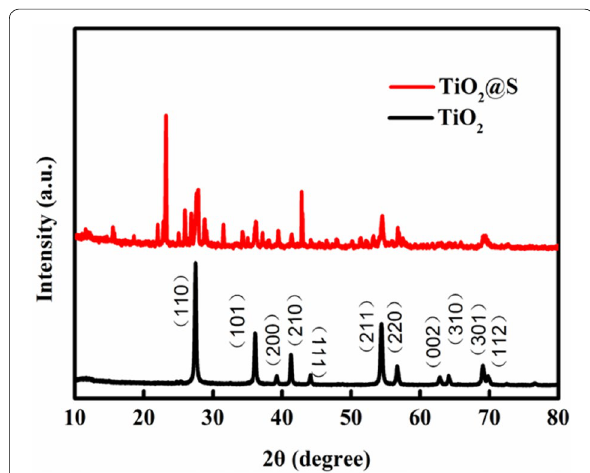
Figure 4 XRD patterns of as-spun electrospun TiO 2 and TiO 2 /S nanofibers